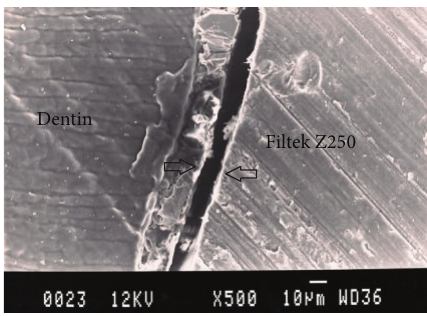
Figure 5: Representative SEM photomicrograph of a Group 5 spec- imen (Filtek Z250, 23 ∘ C). The arrows indicate microgap formation between Filtek Z250 and